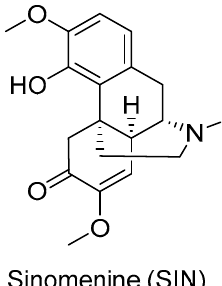
Figure 1. The structure of SIN.